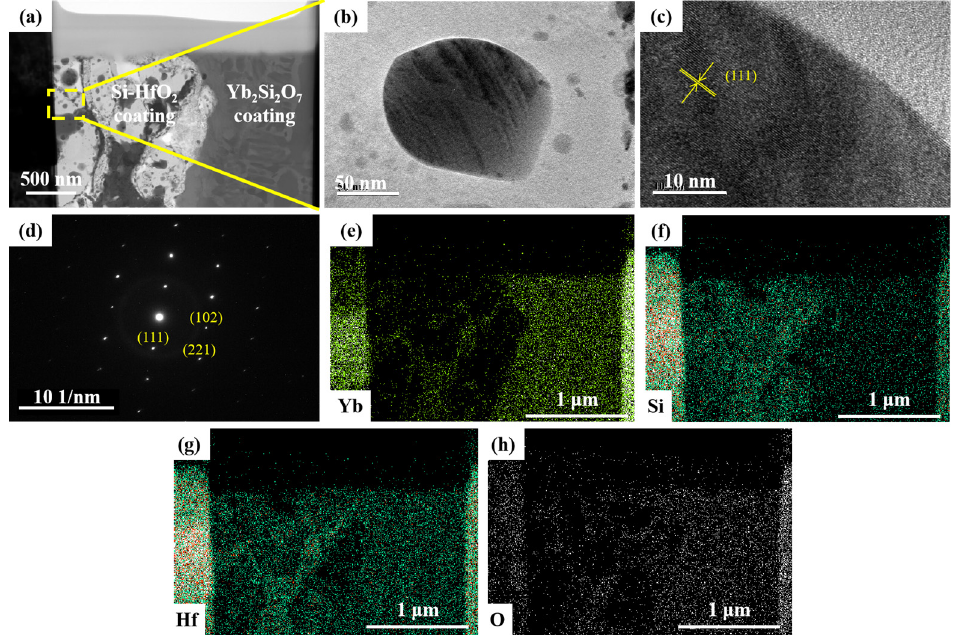
Figure 8. TEM image: ( a ) bright field image of Yb 2 SiO 7 /Si–HfO 2 Interface; ( b ) the TEM patterns of the HfO 2 ; ( c ) HRTEM image of the HfO 2 ; ( d ) the SAED patterns of the HfO 2 . EDS patterns of the Yb 2 SiO 7 /Si-HfO 2 interface: ( e ) Yb; ( f ) Si; ( g ) Hf; ( h ) O.